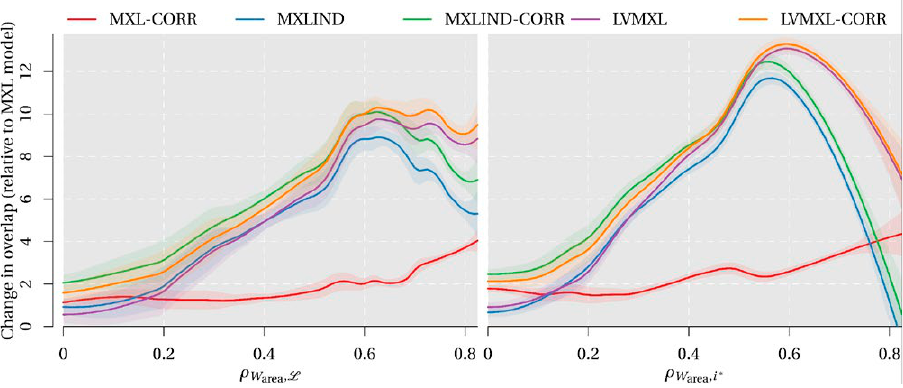
Figure 1. Percentage point difference in overlap of MWTP distributions relative to the true MWTP dis- tribution for area.